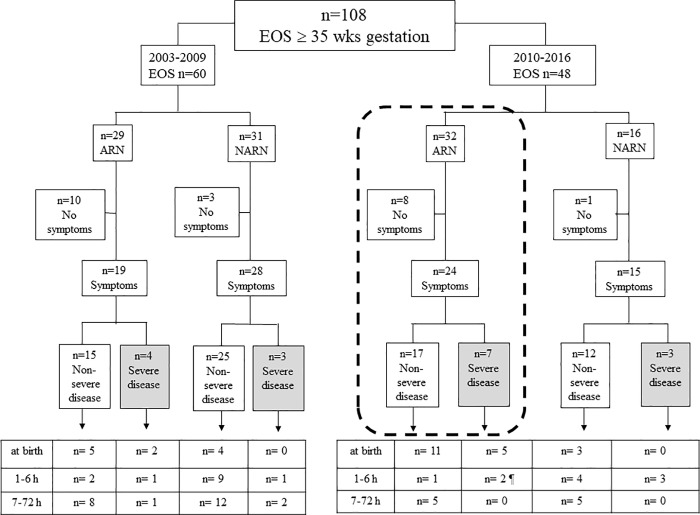
EOS cases (at or above 35 weeks of gestation) in the 2 study periods (2003–2009 vs 2010–2016).Cases are divided according to the presence (or absence) of risk factors, the presence (or absence) of symptoms during the first 72 hours of life and the time of onset of symptoms. Cases of severe disease are shown in the grey boxes. Neonates managed through SPEs are shown in the dashed box.ARN, at-risk neonates; EOS, early-onset disease; h, hours; NARN, not at-risk neonates; wks, weeks. ¶ One neonate with severe disease was unexposed to IAP; he was born preterm (36 weeks of gestation) to an unscreened mother, and symptoms developed at 2 hours of age. Another neonate was treated in labour with 8 doses of clindamycin; he was born after a prolonged membrane rupture (60 hours) and symptoms developed at 4 hours of age.